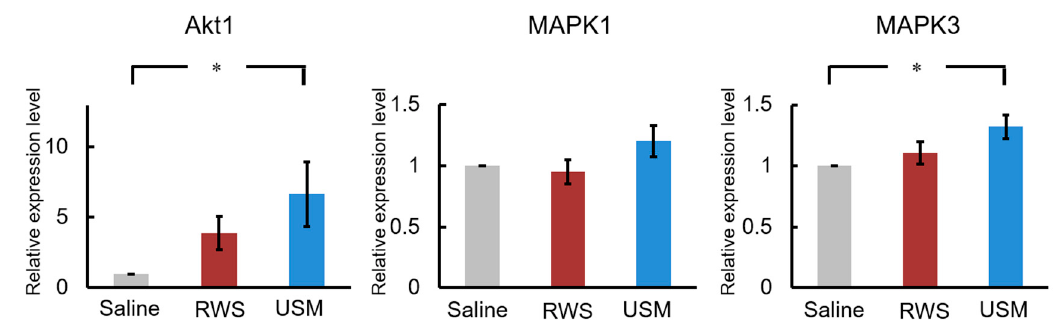
Figure 5. Ultrasound microbubble-mediated IGF-1 treatment increases the mRNA expression of Akt1 and Mapk3 in the cochlea after noise exposure. The combination of ultrasound microbubbles and IGF-1 (USM group), IGF-1 only (RWS group) or saline only (saline group) was administered 24 h after noise exposure. Total RNA was isolated from whole cochleae from the three groups 2 h after treatment. Akt1, Mapk1, and Mapk3 expression levels were quantified by quantitative PCR. The results are expressed as the mean ± SEM; n = 9 for each bar; * p < 0.05. IGF-1, insulin-like growth factor-1; USM, ultrasound microbubble; RWS, round window soaking.